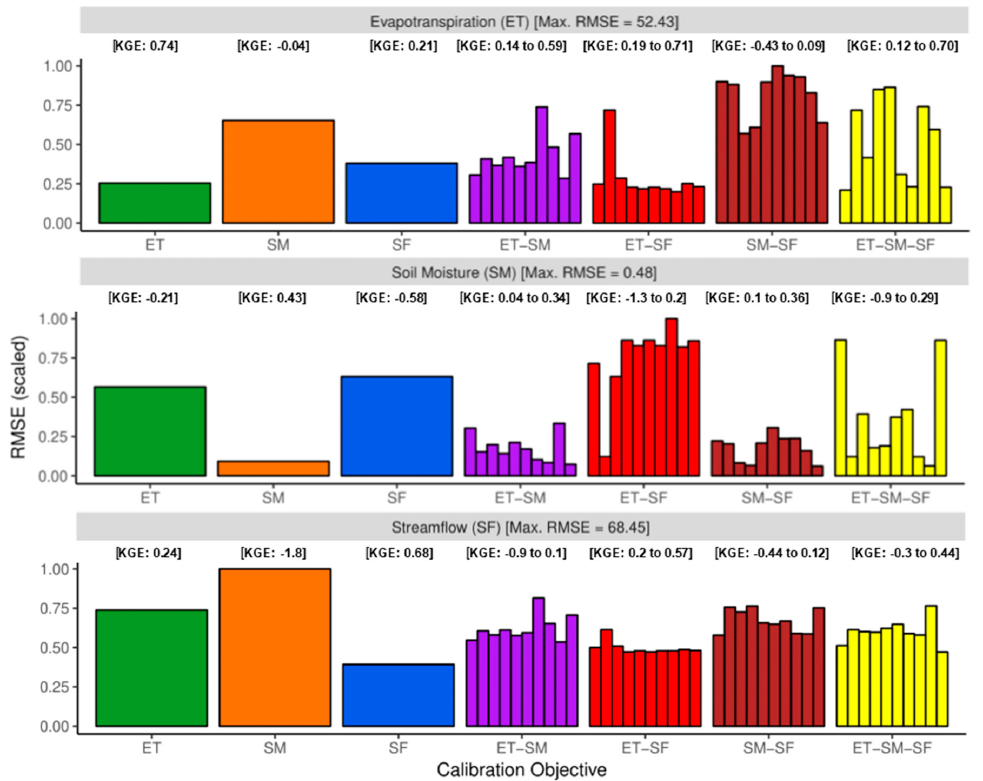
Figure 3. Bar plots of scaled RMSE values of basin averaged monthly ET (top panel), SM (middle panel), and SF (bottom panel) when the Noah-MP model is calibrated with (1) ET, (2) SM, (3) SF, (4) ET–SM, (5) ET–SF, (6) SM–SF, and (7) ET–SM–SF as calibration objectives (x-axis in all three panels). RMSE values for ET, SM, and SF are scaled by the maximum RMSE across the seven calibration cases. The maximum values are provided in the header of each panel within square brackets. The multivariate calibration results are derived by taking 10 samples from di ff erent points on the Pareto fronts. We also present KGE values for each of the calibration cases above each barplot. For multivariate calibration cases, only the range of KGE values from the selected Pareto-optimal parameter sets are